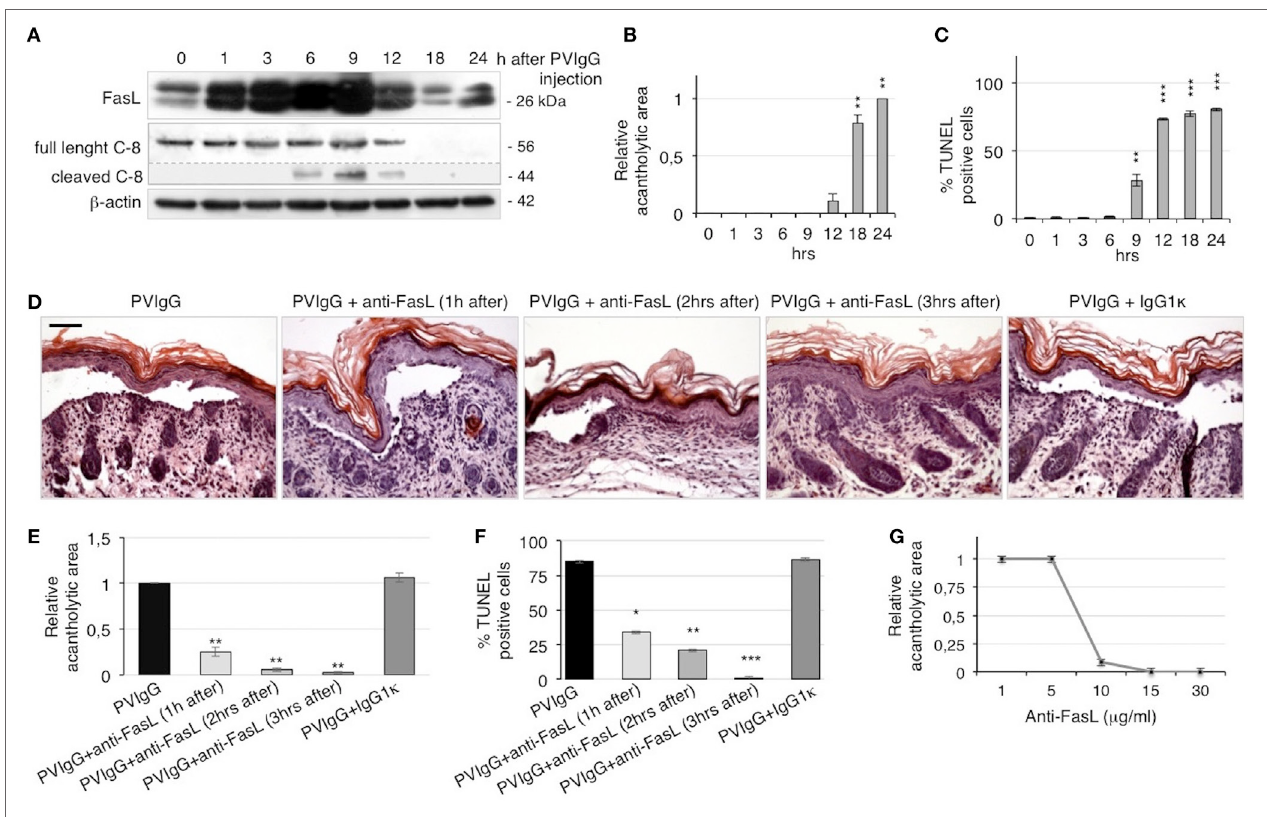
FigUre 3 | Anti-Fas ligand (FasL) antibody (Ab) inhibits blister formation in pemphigus in vivo . (a–c) Neonatal mice were injected with pemphigus autoantibodies (PVIgG), sacrificed at various time points, and analyzed for the presence of FasL, acantholysis, and apoptosis activation. (a) FasL protein expression and caspase-8 activation in mouse skin extracts. (B) Relative acantholytic areas and (c) the percentage of TUNEL-positive cells in mouse skin. Each time point was compared to 0 h for statistical analysis (means ± SEM; ** P < 0.01; *** P < 0.001 per one-way ANOVA; n = 5 animals/each time point). (D–F) Neonatal mice were injected with normal human IgG (NIgG) or PVIgG, treated with anti-FasL Ab at the indicated time points and sacrificed at 20 h post PVIgG injection. IgG1 κ was used as an isotype control for the anti-FasL Ab. (D) Hematoxylin and eosin staining of the neonatal mouse skin. Scale bar = 100 µm. (e) Relative acantholytic areas in mouse skin and (F) the percentage of TUNEL-positive cells in mouse skin (means ± SEM; * P < 0.05; ** P < 0.01; *** P < 0.001 per Student’s t -test, compared with PVIgG; n = 5 animals/each treatment). (g) Mice were treated with PVIgG and, 3 h later, with decreasing doses of anti-FasL Ab. Relative acantholysis areas were measured in at least three different fields ( n = 5 animals/each